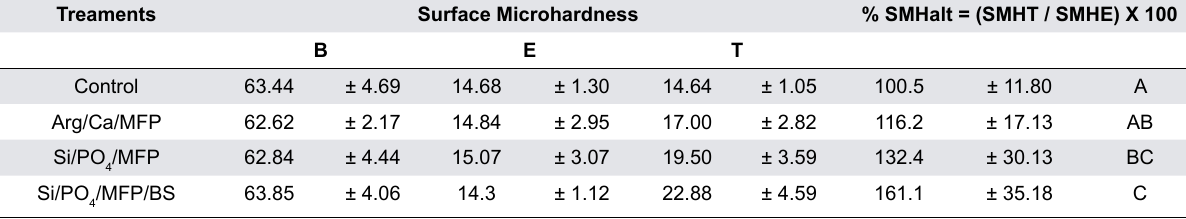
Table 3- Mean percentage (Standard deviation) of microhardness data and results of Tukey test for dentin